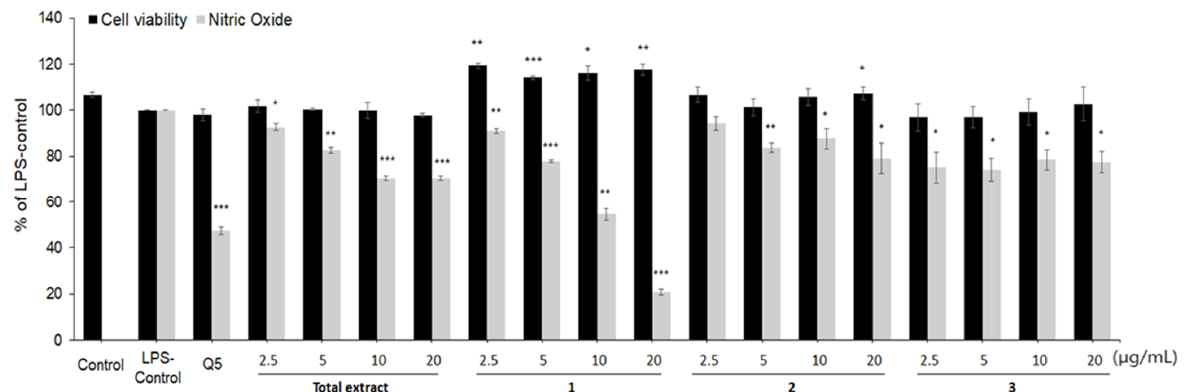
Figure 2. Effects of L. lucidum fruits extract and compounds 1–3 on the NO production and cell viability in LPS-stimulated RAW264.7 macrophages. All data are presented as the mean ± SEM ( n = 3). Quercetin (Q5, 5 μ g/mL) was used as the positive control. * p < 0.05, ** p < 0.01 and *** p < 0.001 indicate significant differences compared to the LPS control group.